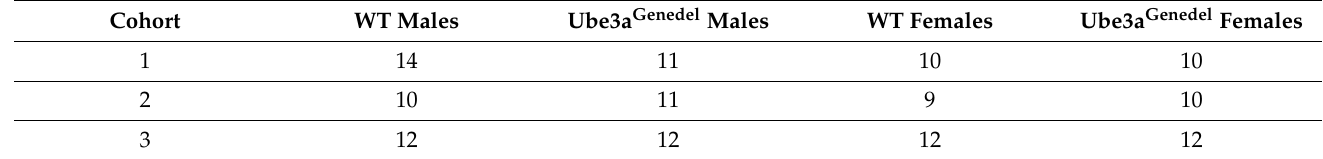
Table 2. Sample sizes of animals used for cohorts (number of animals used in groups of every cohort). Cohort WT